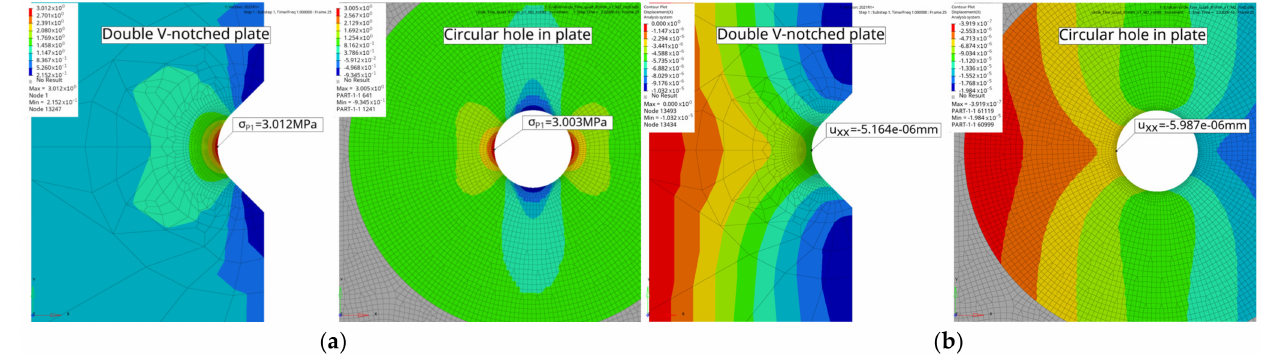
Figure 22. Comparison of blunt notched V-plate (mesh ‘K1V_H10_A1_PHI90_RHO1_E_TE’) and circular hole-in-plate (mesh ‘circle_fine_quad_R1mm_v1’): ( a ) Absolute max principal stress; and ( b ) Displacement in the x-axis.